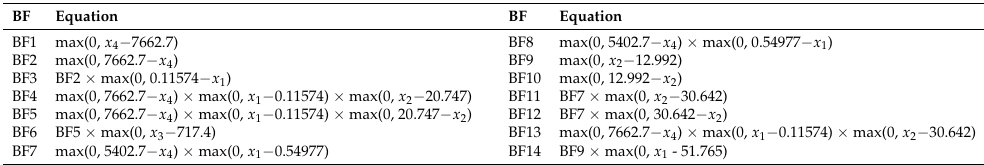
Table 18. Basis functions of the piecewise-linear MARS model of melt temperature based on dy- namic